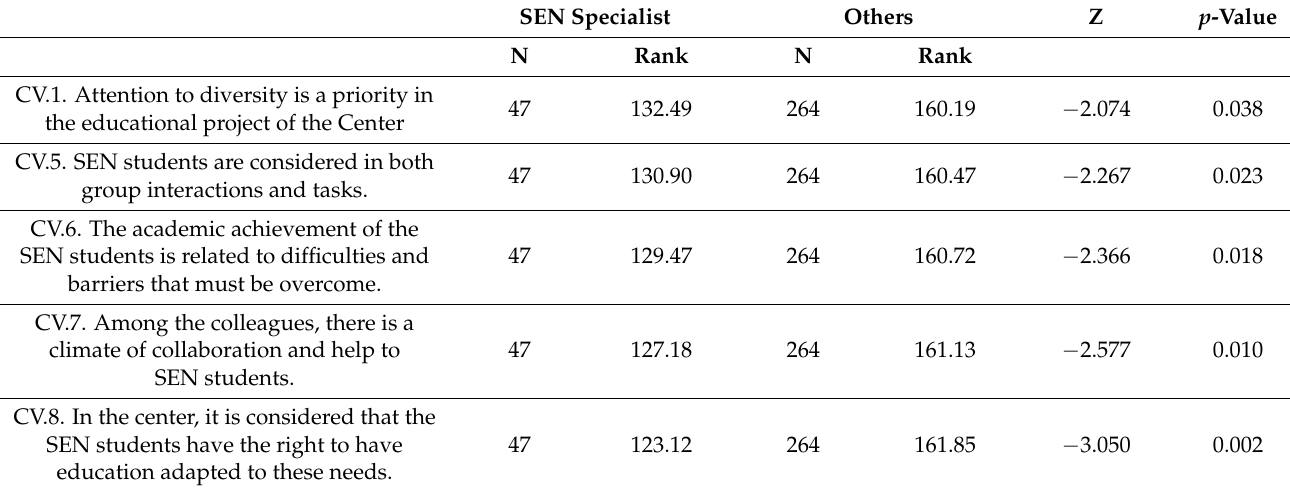
Table 10. Analysis of the Mann Whitney U according to teachers’ professional